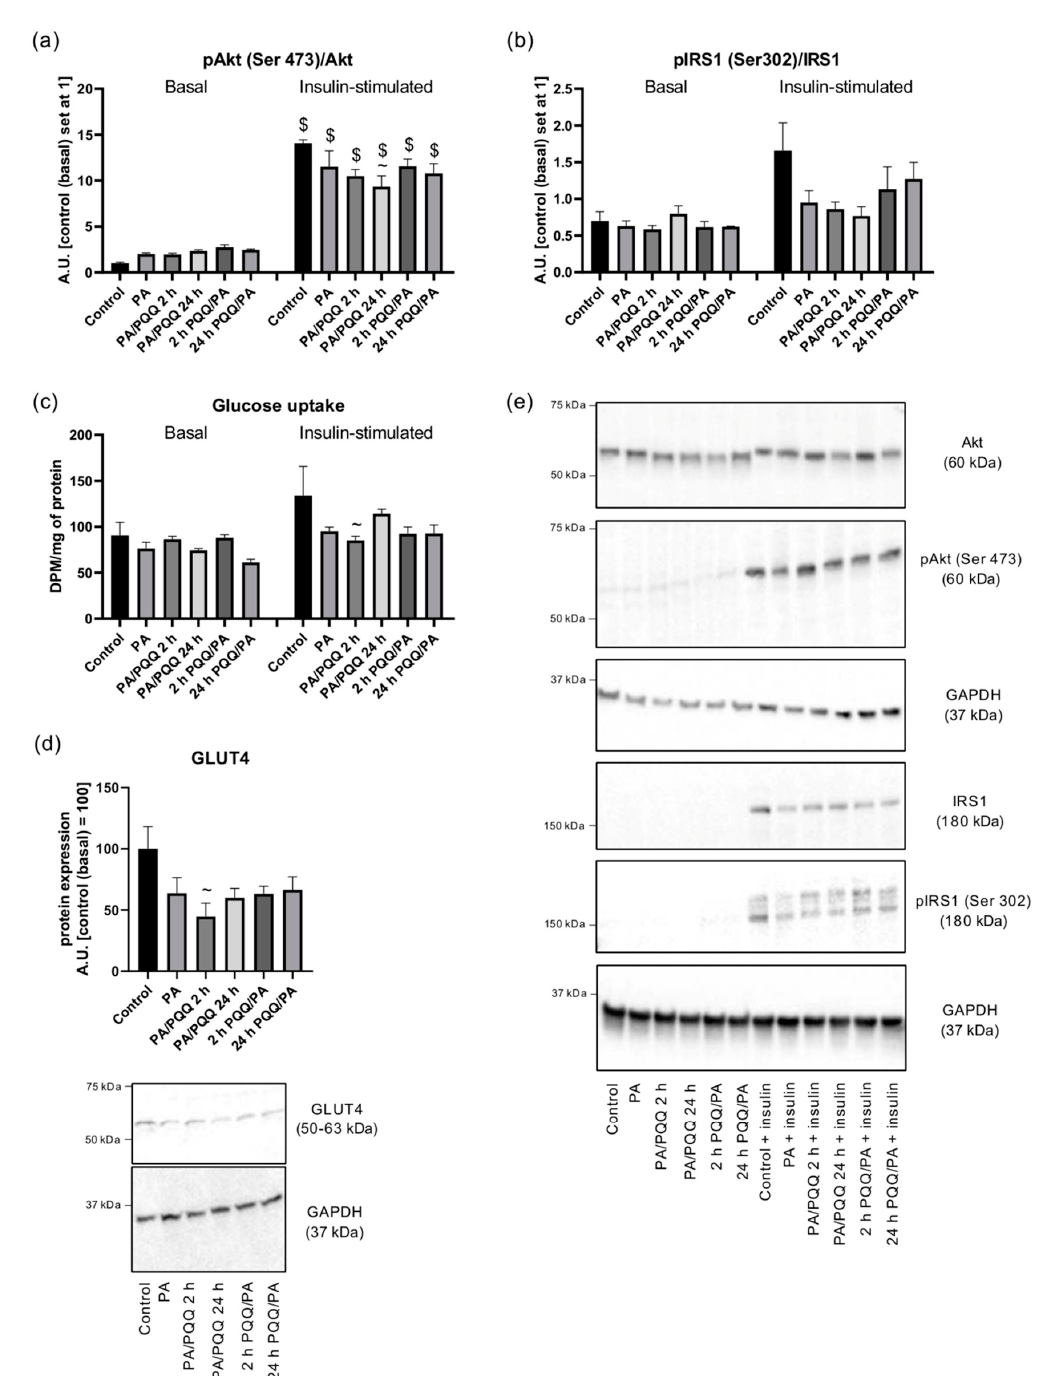
Figure 8. Effects of short- and long-time incubation with PQQ on the protein expression of ( a ) pAkt/Akt ratio, ( b ) pIRS1/ insulin receptor substrate (IRS1) ratio, ( c ) glucose uptake, and ( d ) glucose transporter 4 expression in L6 myotubes. ( e ) Representative Western Blot data. Unless stated otherwise, the control is set as 100 (protein content) or 1 (ratio). The values are presented as mean ± SEM and are based on six independent determinations. ANOVA with a post hoc Tukey’s test was applied. ~ p < 0.05, study groups versus control; $ p < 0.05, insulin-stimulated versus basal conditions. ANOVA: analysis of variance; GAPDH: glyceraldehyde 3-phosphate dehydrogenase; PA: palmitic acid; PQQ: pyrroloquinoline quinone.